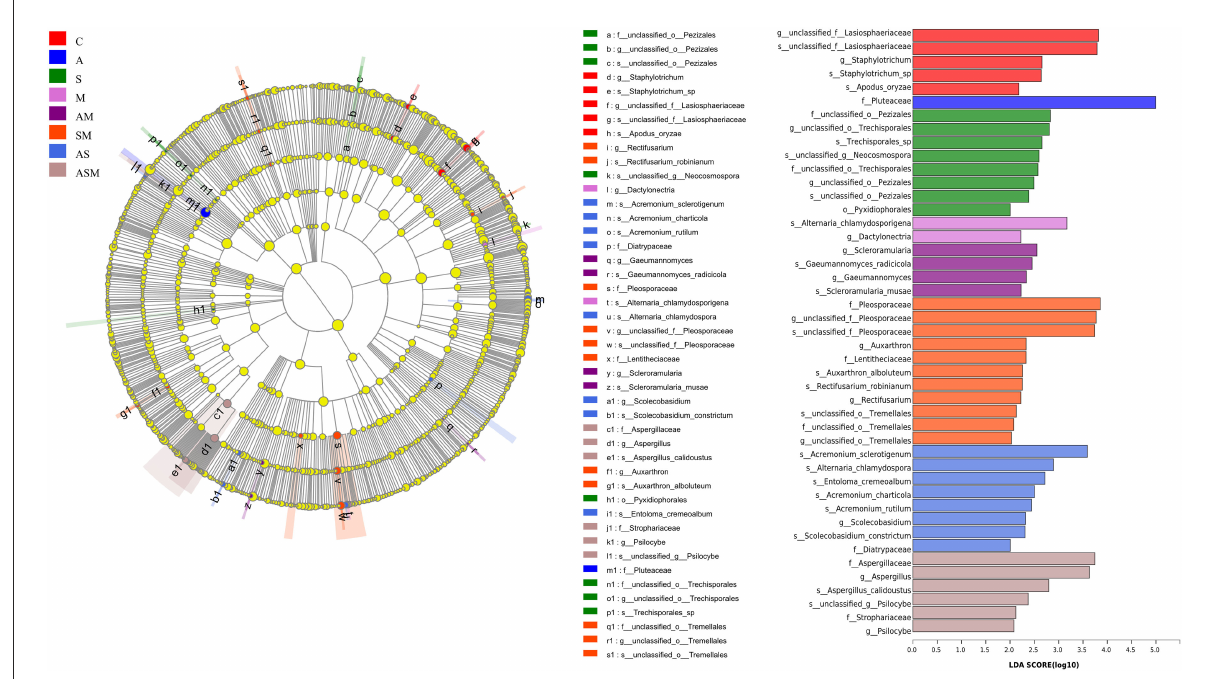
FIGURE7 Indicator fungal species with LDA scores of 2 or greater in the rhizosphere of A. adsurgens under different inoculation treatments. LDA Effect Size (LEfSe) algorithm was used on OTUs level to determine taxa that were differentially represented among inoculation treatments. C, non-inoculated control; A, inoculation with Alternaria chlamydospora ; S, inoculation with Sarocladium kiliense ; M, inoculation with Monosporascus sp.; AS, co-inoculation of Alternaria chlamydospora and Sarocladium kiliense ; AM, co-inoculation of Alternaria chlamydospora and Monosporascus sp.; SM, co-inoculation of Sarocladium kiliense and Monosporascus sp.; ASM, combination inoculation of the three